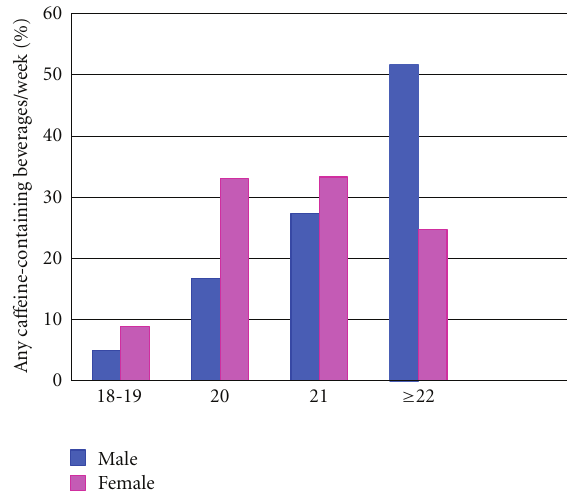
Figure 3: Prevalence of poor sleep quality in relation to age and sex.